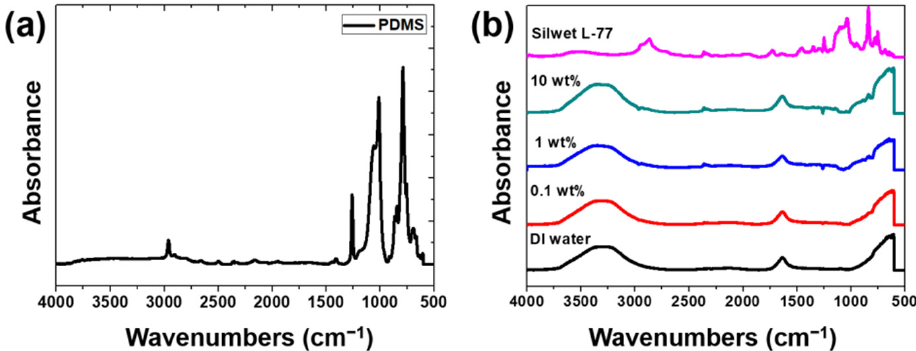
Figure 1. FTIR-ATR results of ( a ) PDMS and ( b )